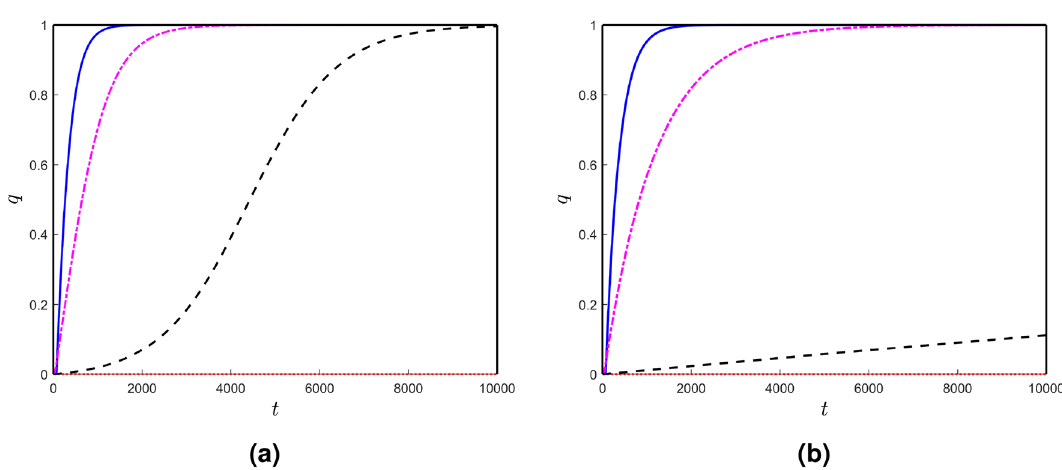
Figure 5. (Color online) Node-wise damage dynamics over time for local and nonlocal interactions in the neuronal damage model: ( a ) local and ( b ) nonlocal with σ = 0.25